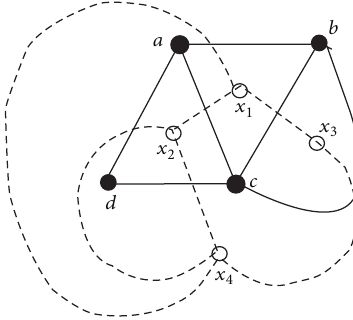
Figure 5: Intuitionistic fuzzy dual